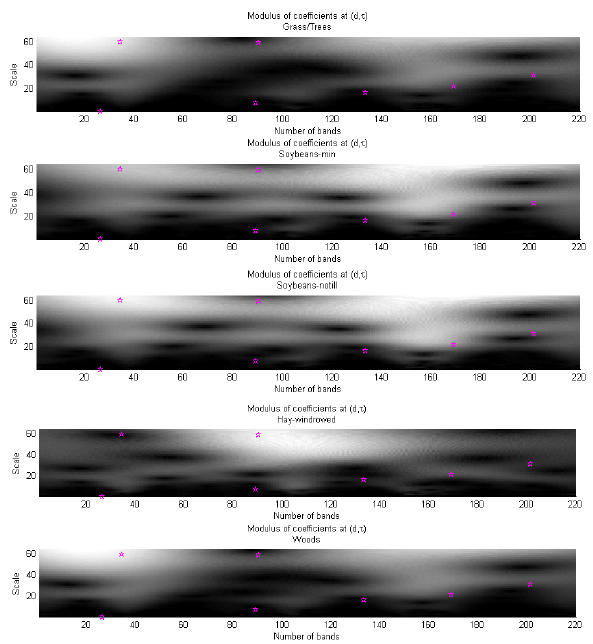
Figure 6. Modulus of coefficients and learned wavelons of mode 5